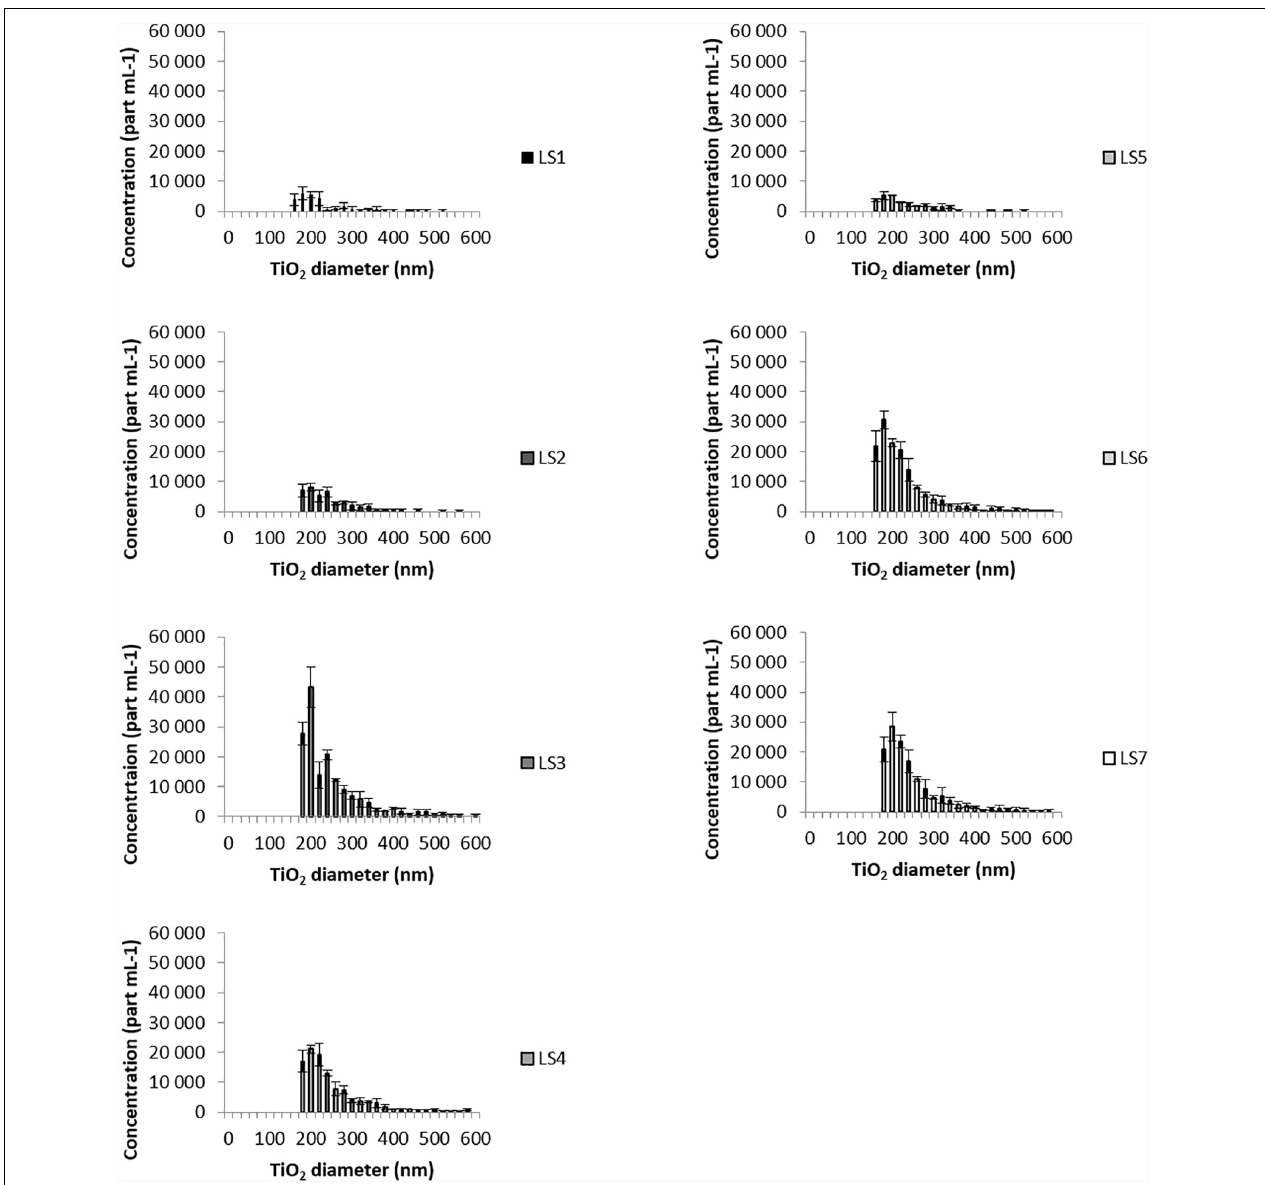
FIGURE 4 | Size distribution of TiO 2 NPs in Loire River water